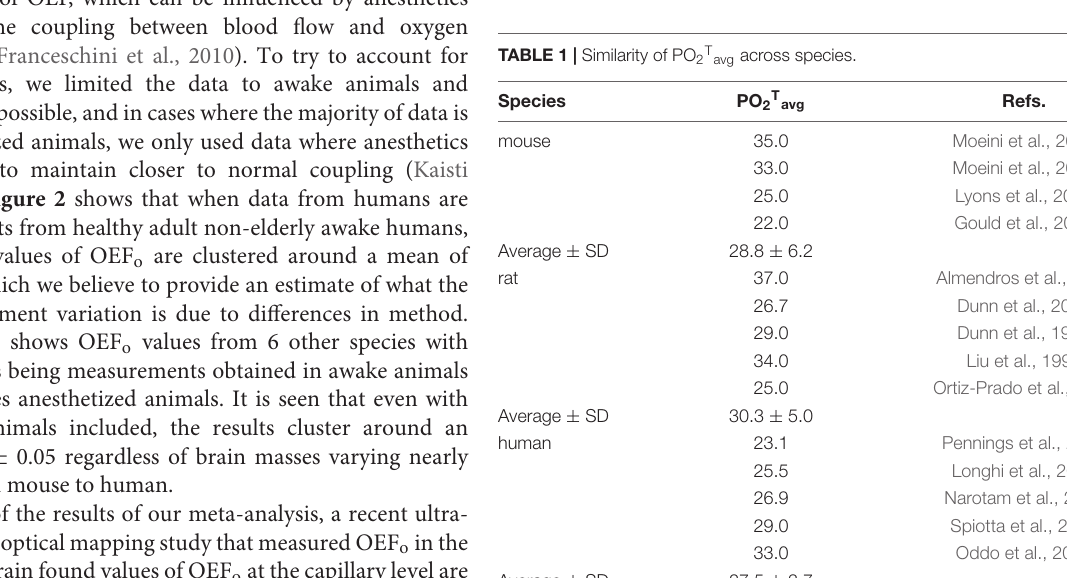
Average values of PO 2T (in torr) measured in the undisturbed, awake cerebral cortex of humans, rats, and mice. Although the available data is limited, it